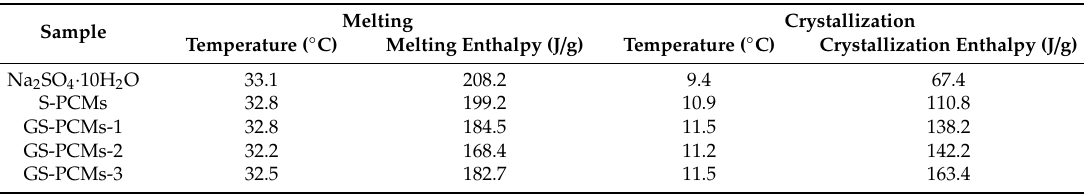
Table 2. Phase change performances of the pure Na 2 SO 4 · 10H 2 O and composite PCMs.